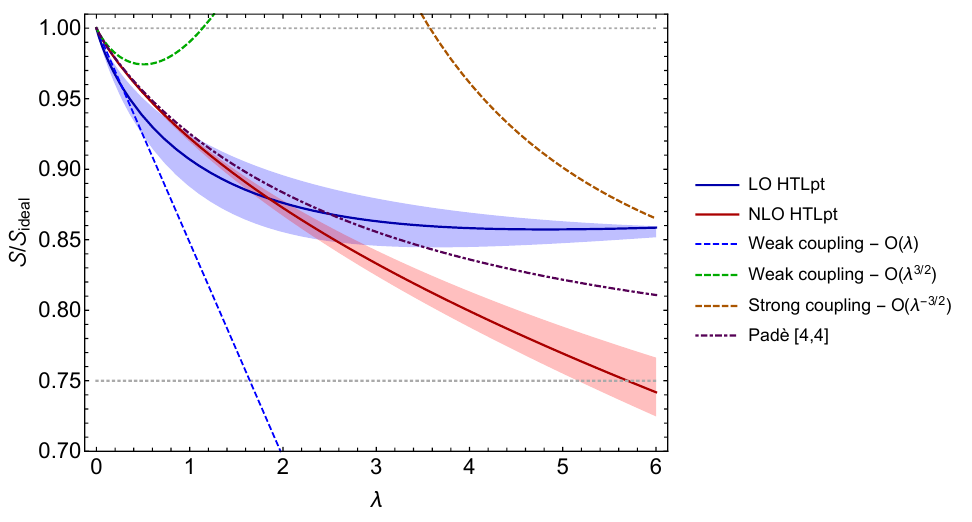
Figure 5 . Comparison of the LO and NLO HTLpt results for the scaled entropy density with prior results from the literature. A detailed description of the various lines can be found in the